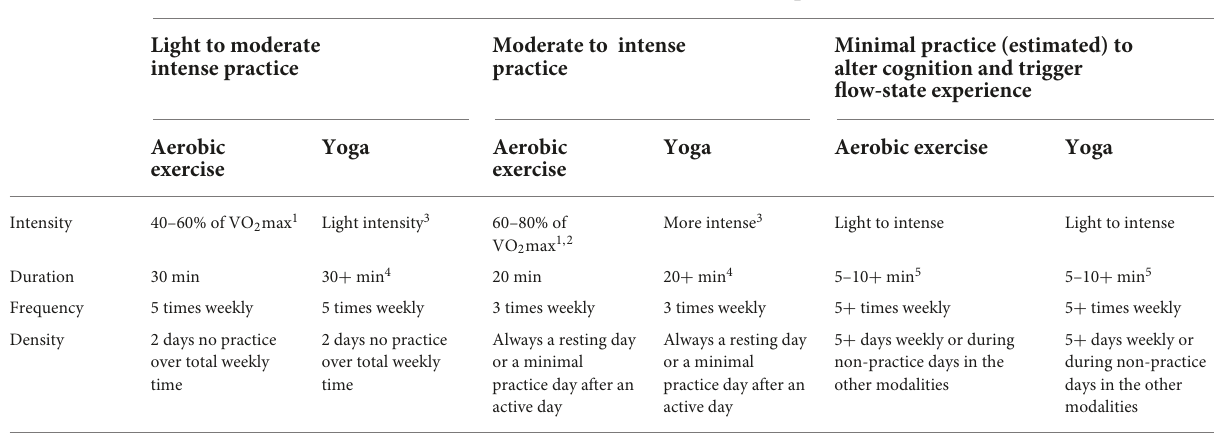
TABLE 5 PE augmented mindfulness: preliminary guidelines for research and protocol